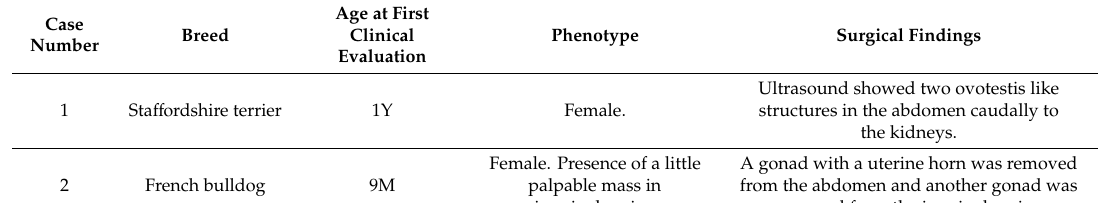
Table 2. Clinical description of the four analyzed dogs.